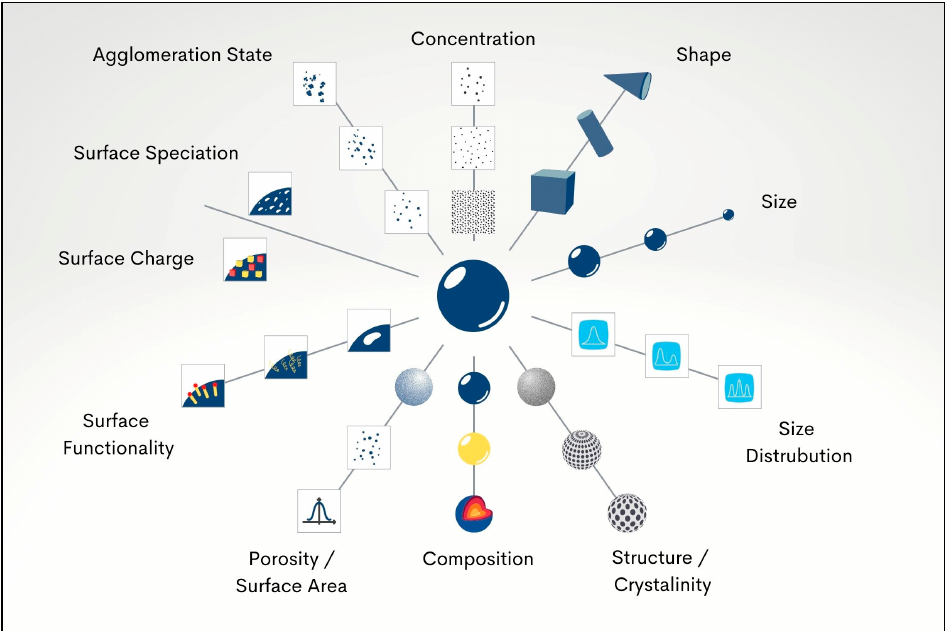
Figure 1. Physio-chemical parameters which determine the biological impact of nanoparticles.